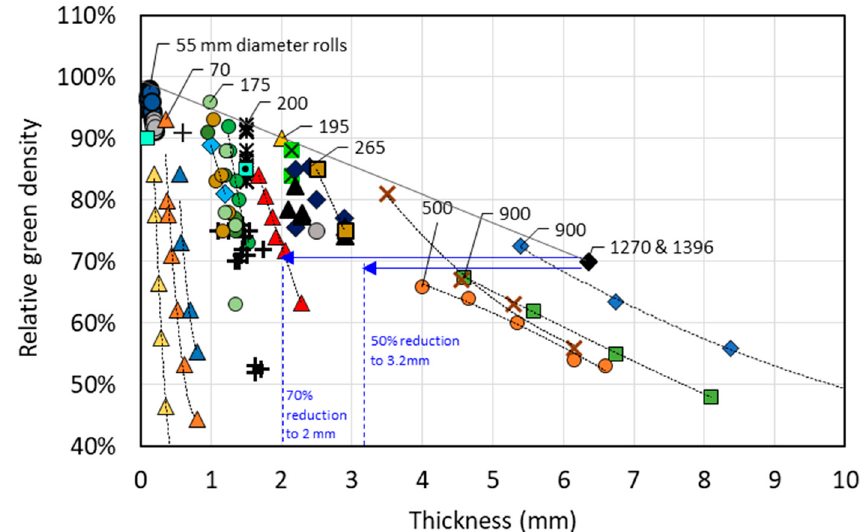
Figure 2. Green density and thickness for titanium and Ti-6Al-4V strips produced using various roll diameters [2–18]. Color and symbol combinations indicate different studies. Numbers next to symbols indicate roll diameters, which only some papers specified. Line drawn across the highest density points shows decreasing maximum density for increasing strip thickness.